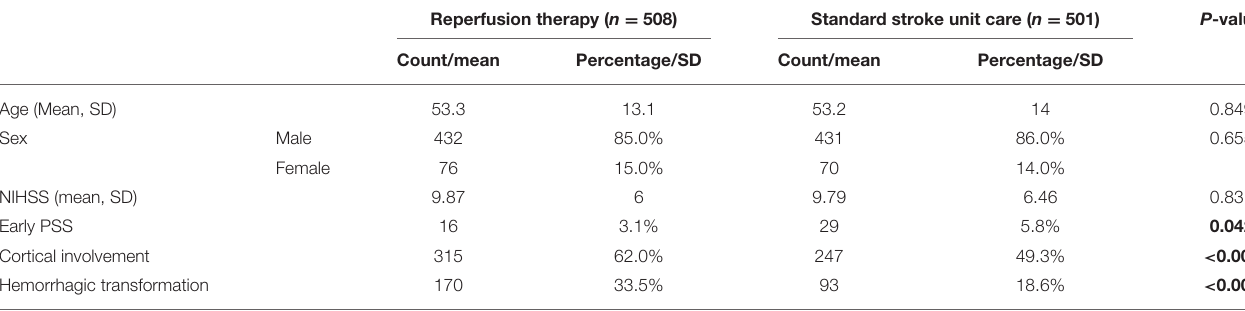
TABLE 1 | Characteristics of patients with ischemic stroke receiving reperfusion treatment or standard stroke unit care.